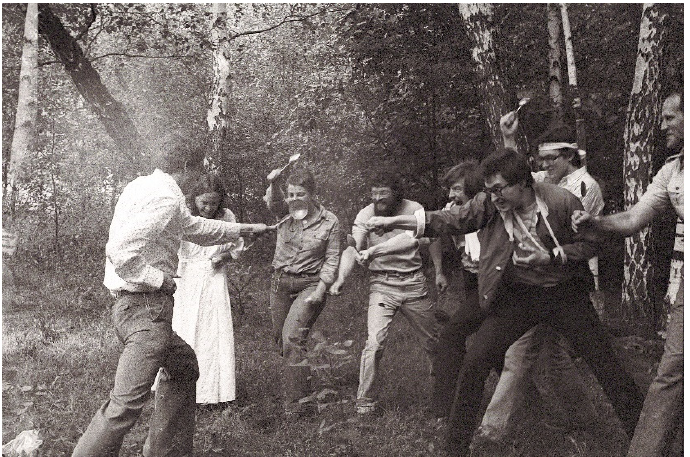
Figure 26. SZ. Self-defense Courses Against Things. 1982. Black-and-white photograph of action. Courtesy of the artists.